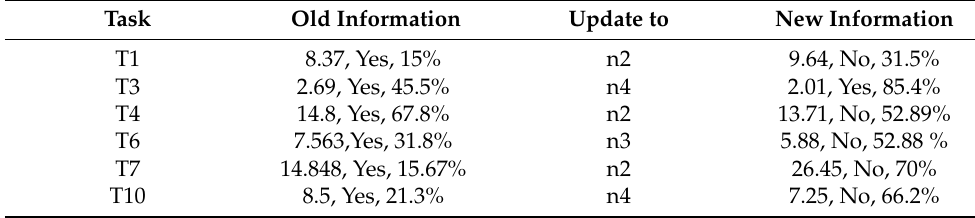
Table 2. T k Information updating according to suitable